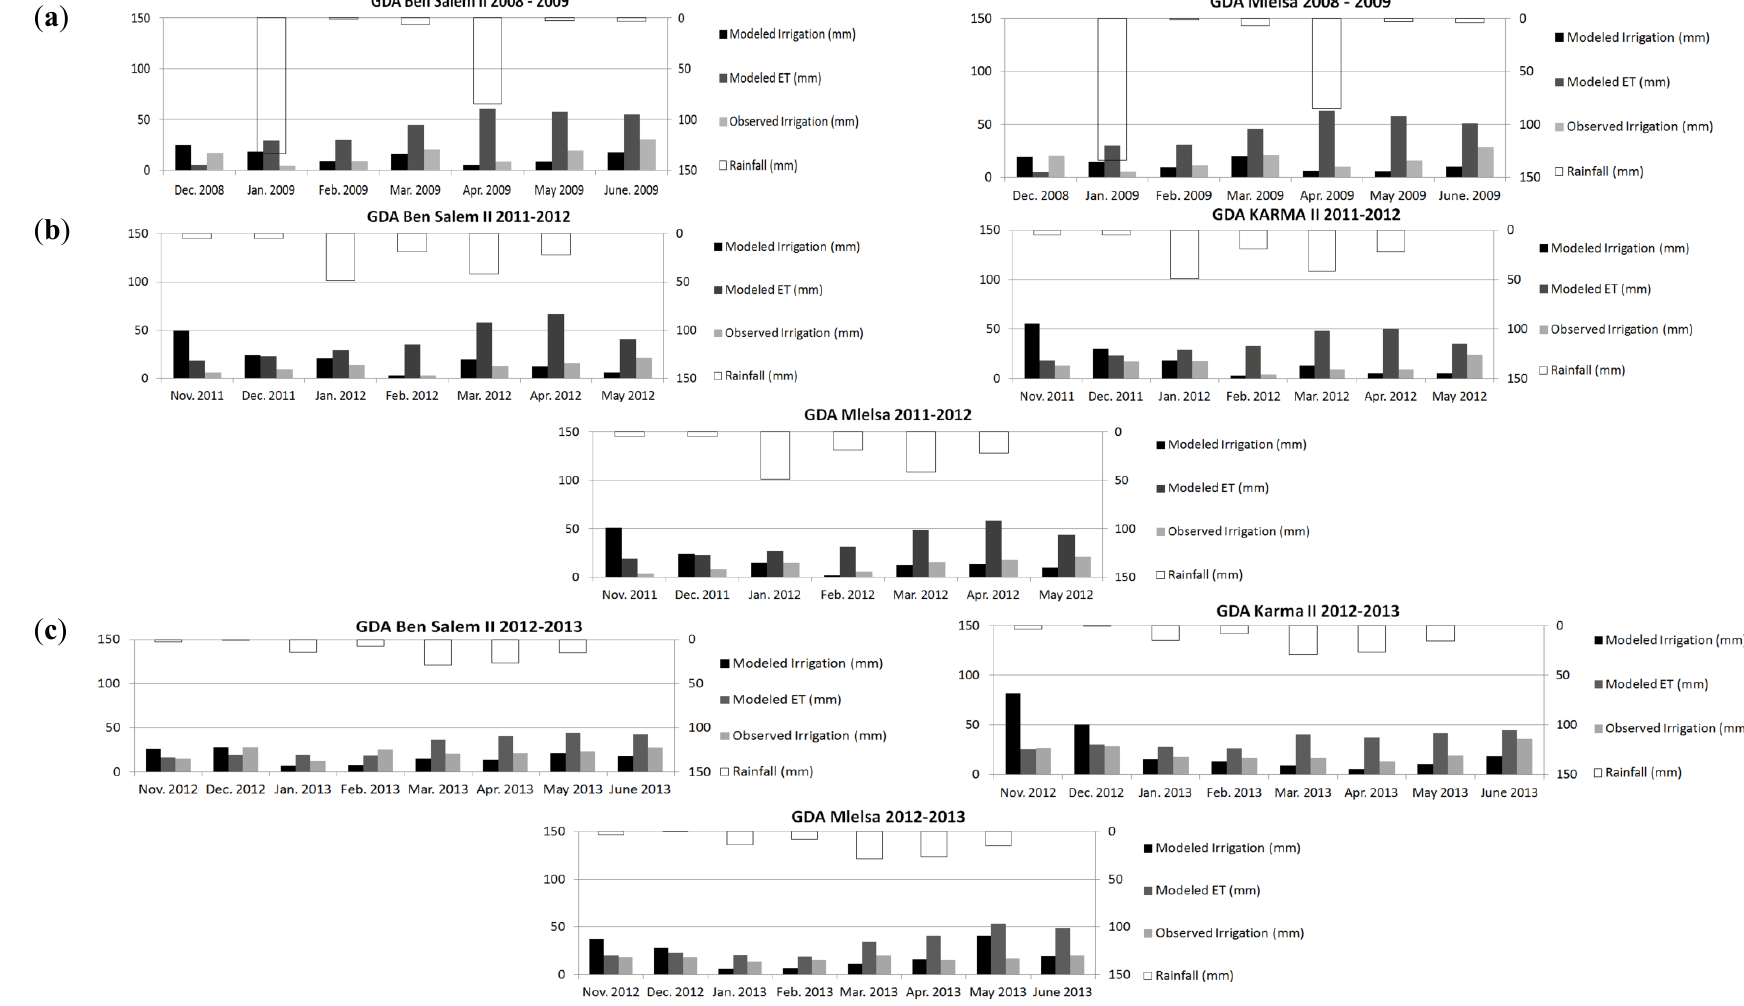
Figure 8. Comparison between surveyed and SAMIR (SAtellite Monitoring of IRrigation) estimated irrigation depth at seasonal scale for